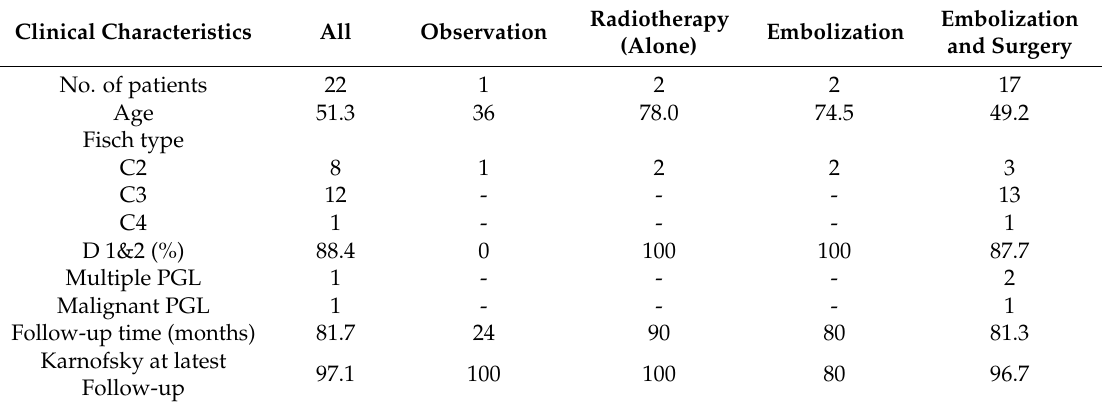
Table 2. Clinical characteristics of the